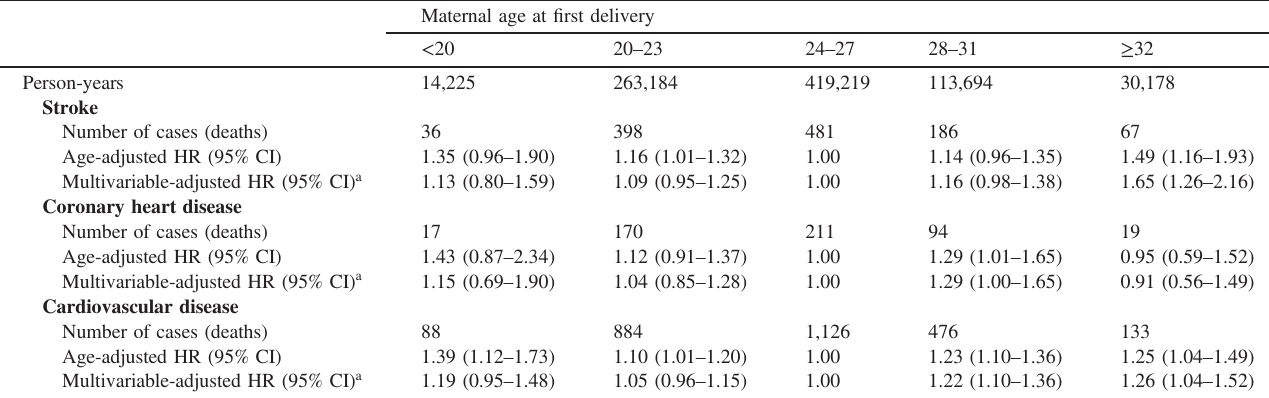
Table 3. Hazard ratios and 95% con fi dence intervals of mortality from cardiovascular disease according to maternal age at fi rst